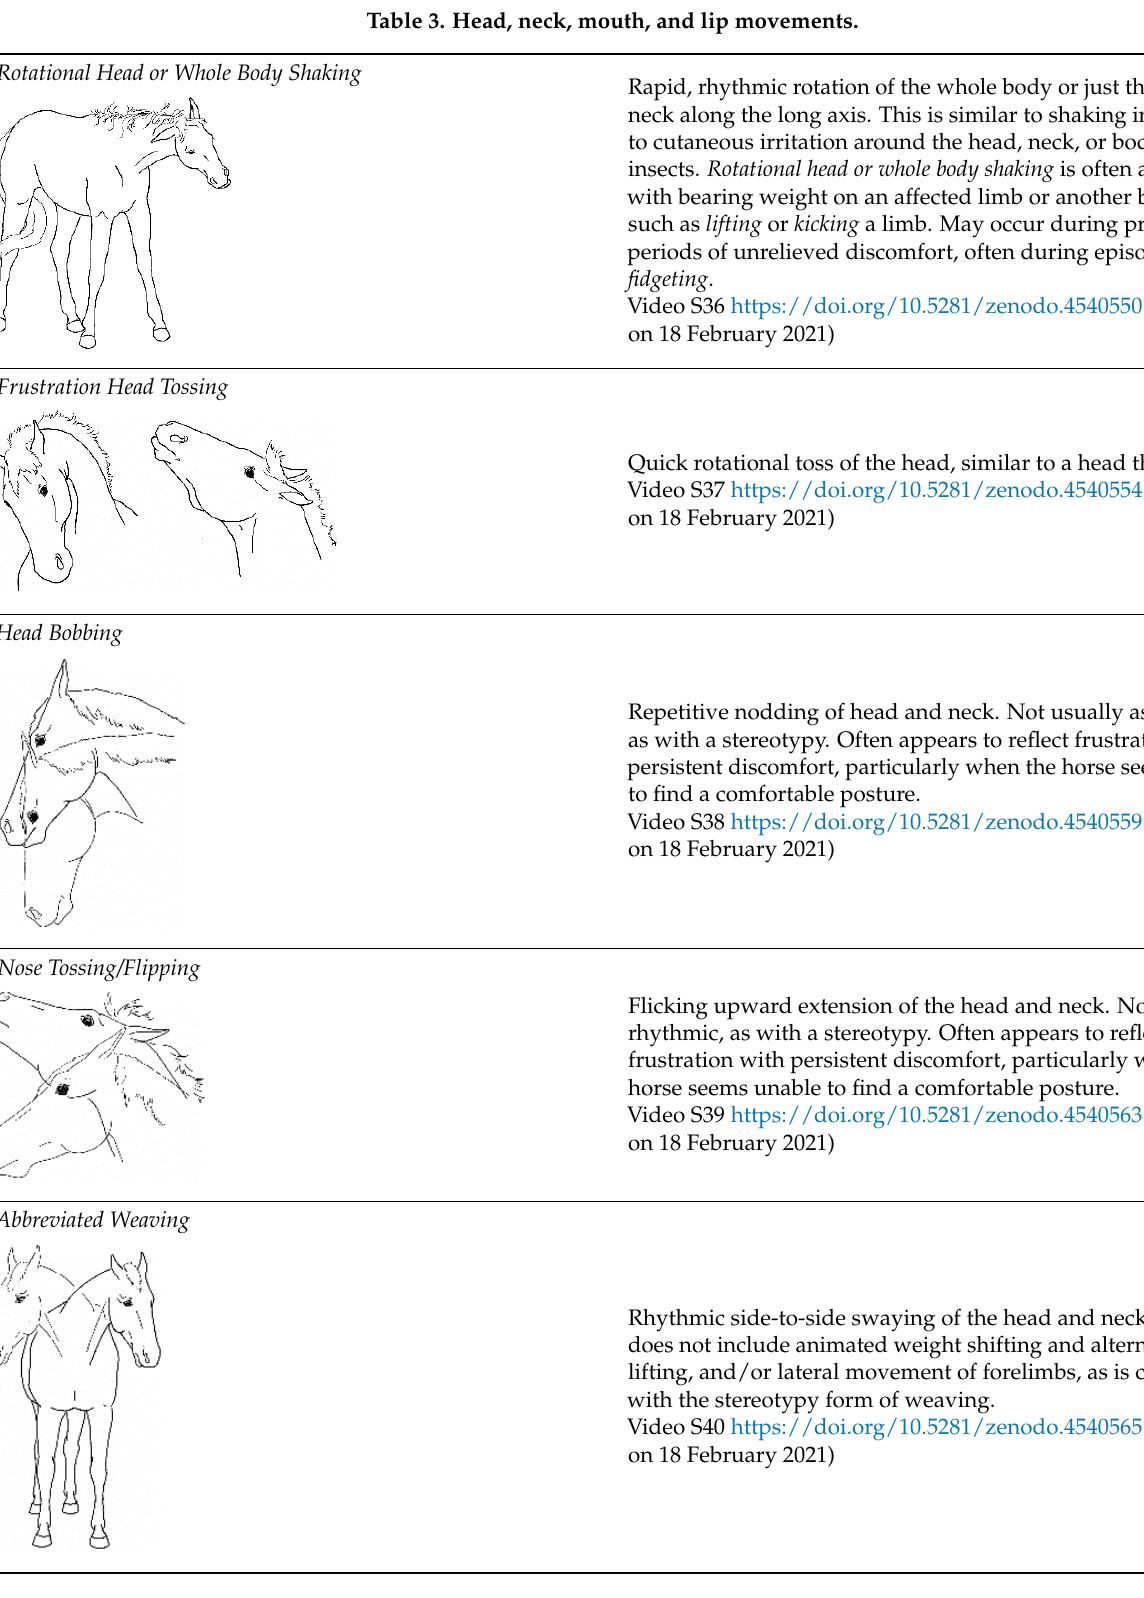
Table 3. Head, neck, mouth, and lip